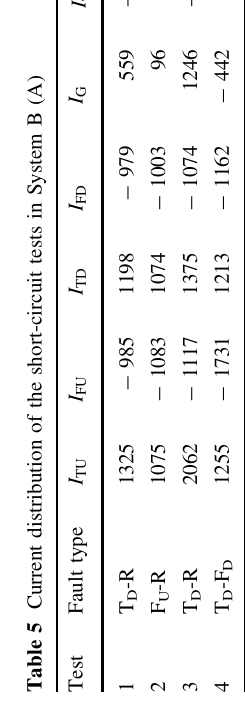
Fig. 3 Current distributions of the short-circuit tests shown in Table 2. a The 2nd test. b The 4th test